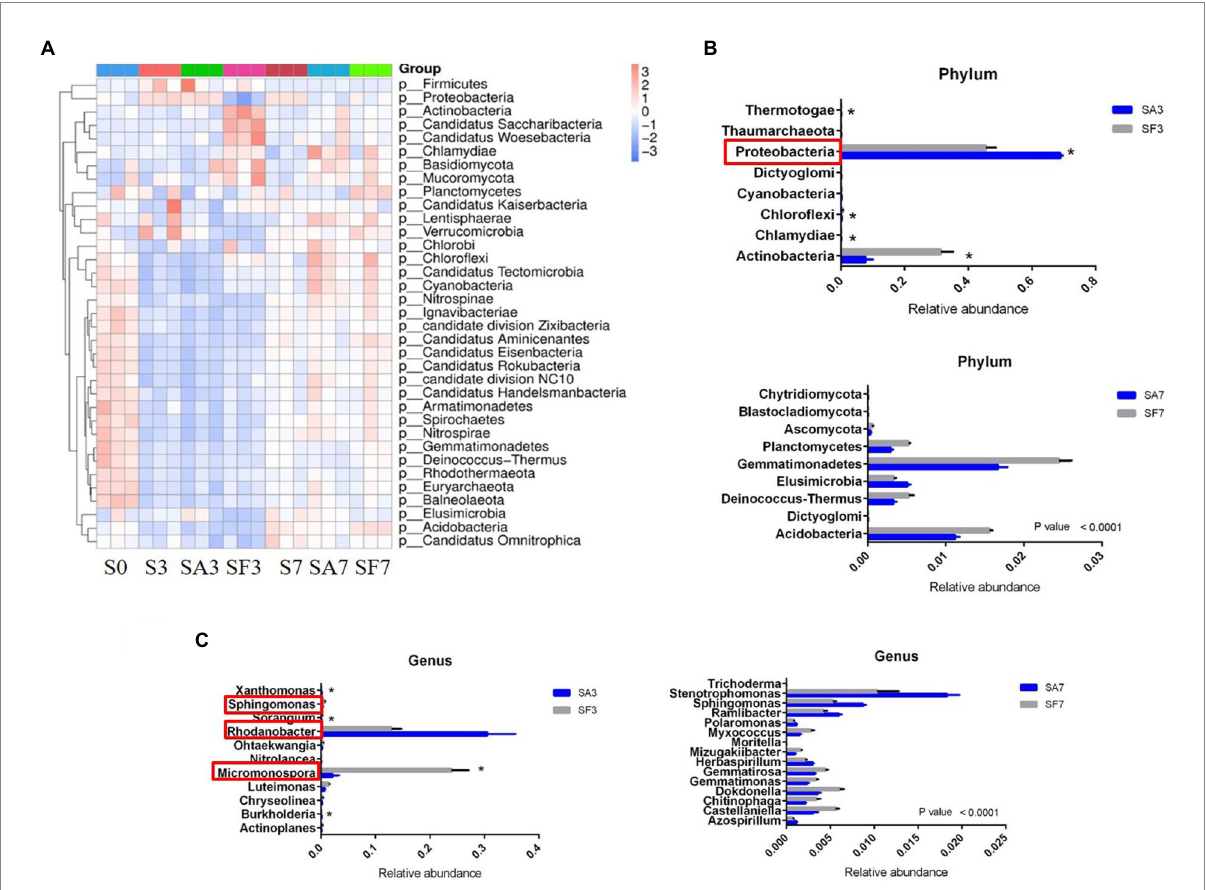
FIGURE 4 Dynamic changes in the significantly abundant rhizosphere microbial communities. (A) Heatmap of the dynamic changes in different phyla among the various soil groups. (B) Bar plots showing the significant differences in relative abundance of the main phyla. (C) Bar plots showing the significant differences in relative abundance of the main genera. Three biological replicates per samples were analyzed. Data are expressed as mean ± SE ( n = 3). Multiple t -tests (* p ≤ 0.01). S0, Mock-inoculation control, before treatment; S3, mock-inoculation control, 3 dpi; S7, mock- inoculation control, 7 dpi; SA3, SA + FON treatment, 3 dpi; SA7, SA + FON treatment, 7 dpi; SF3, FON treatment, 3 dpi; SF7, FON treatment, 7 dpi; FON, Fusarium oxysporum f. sp. niveum ; SA, salicylic acid; dpi, days